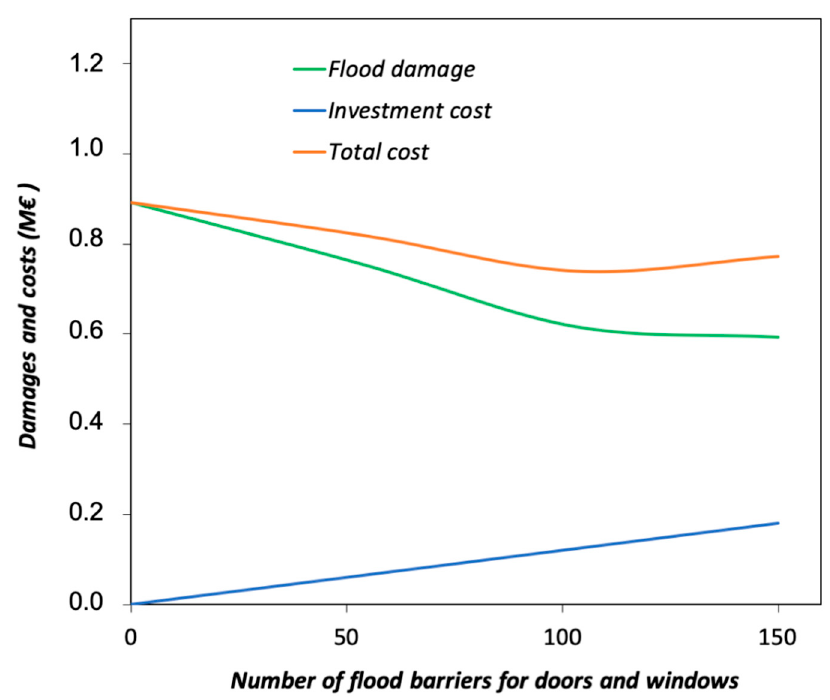
Figure 15. Cost–benefit analysis for scenario 3.